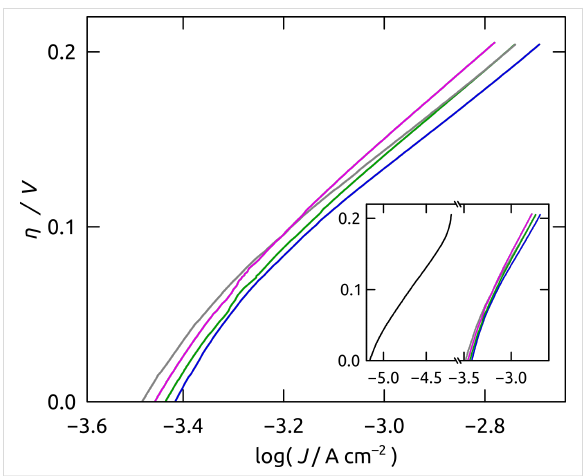
Figure 11: Tafel plots of nanoporous Ru/C electrodes of various lengths 11 ≤ L ≤ 24 μ m in quasi-steady-state conditions. Tafel plots were obtained from linear sweep voltammetry (scan rate 5 mV s − 1 ) measured from +0.79 ≤ E ≤ +1.00 V vs Ag/AgCl (corresponding over- potentials 0.00 ≤ η ≤ 0.21 V). Average log J values for a minimum of 4 samples are presented for 11 μ m (gray line), 13 μ m (blue